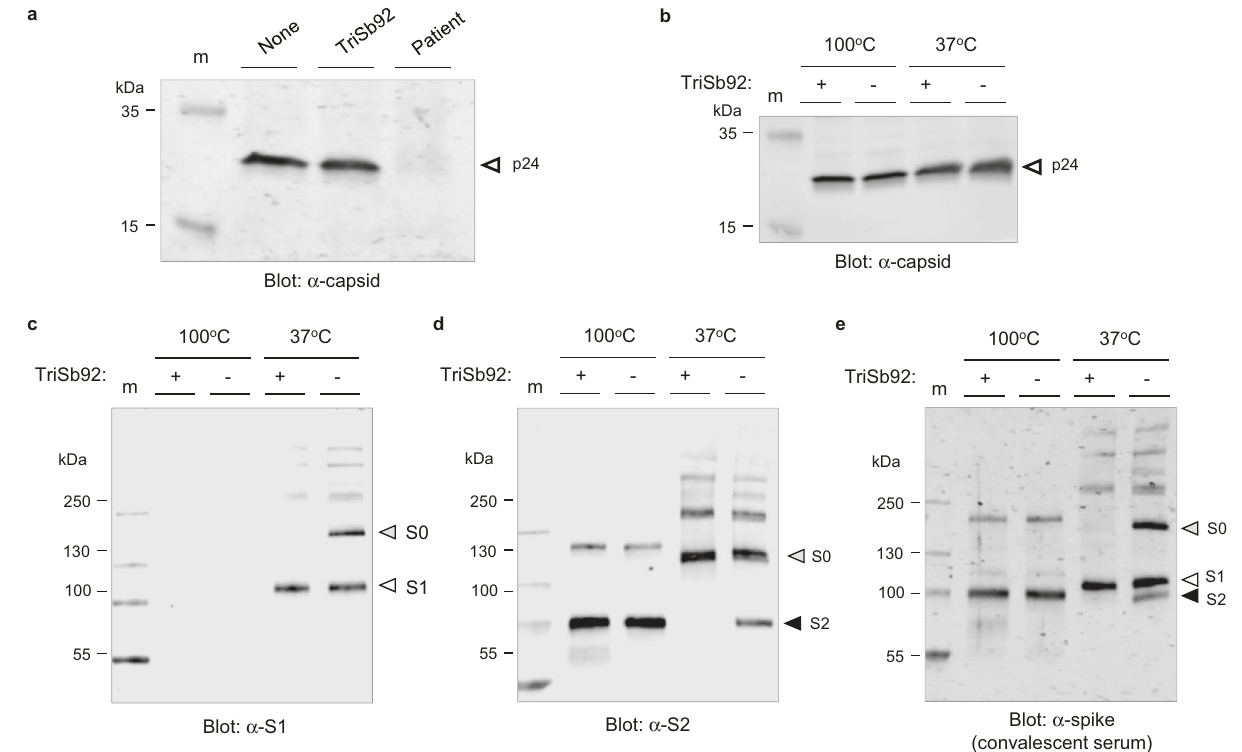
Fig. 3 | TriSb92 does not preventvirus attachmentto target cells butprevents infection by inducing a conformational change in spike. a Spike-decorated pseudoviruses were treated with TriSb92, COVID-19 convalescent serum (Patient), orleftuntreated(None)beforeincubationwithACE2-expressingHEK293cells.The amount of cell-associated pseudoviral capsid protein (p24) after washing of the cultures was determined by Western blotting. b – e Spike-pseudotyped virions treated (+) or not treated ( − ) with TriSb92 were lysed in SDS-PAGE loading buffer